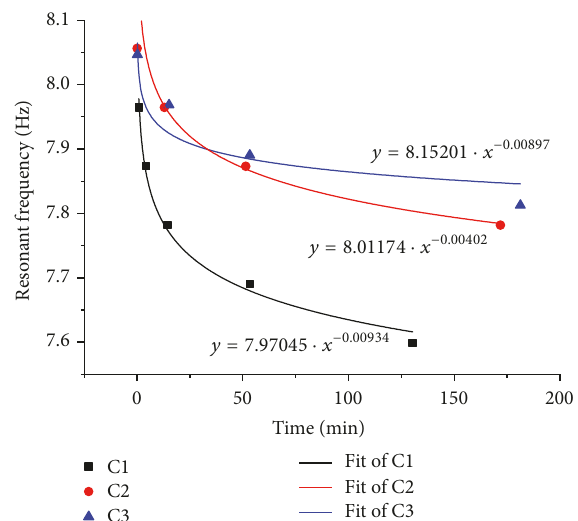
Figure 19: The variation and fitting curves of resonant frequency in Group